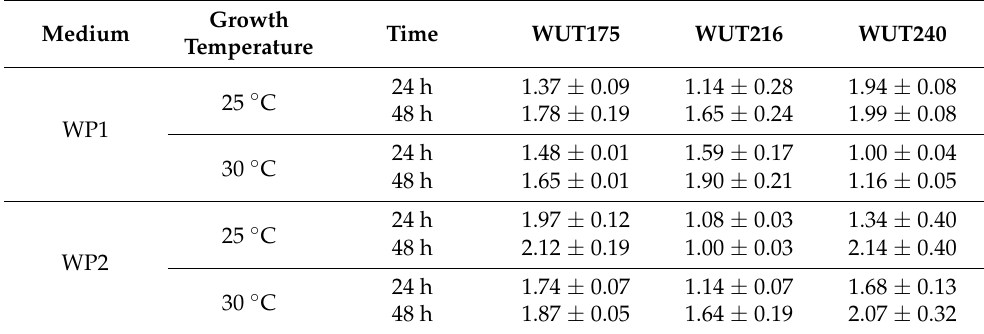
Table 2. 2-PE concentrations [g L − 1 ] achieved in batch cultures of K. lactis WUT175 and K.